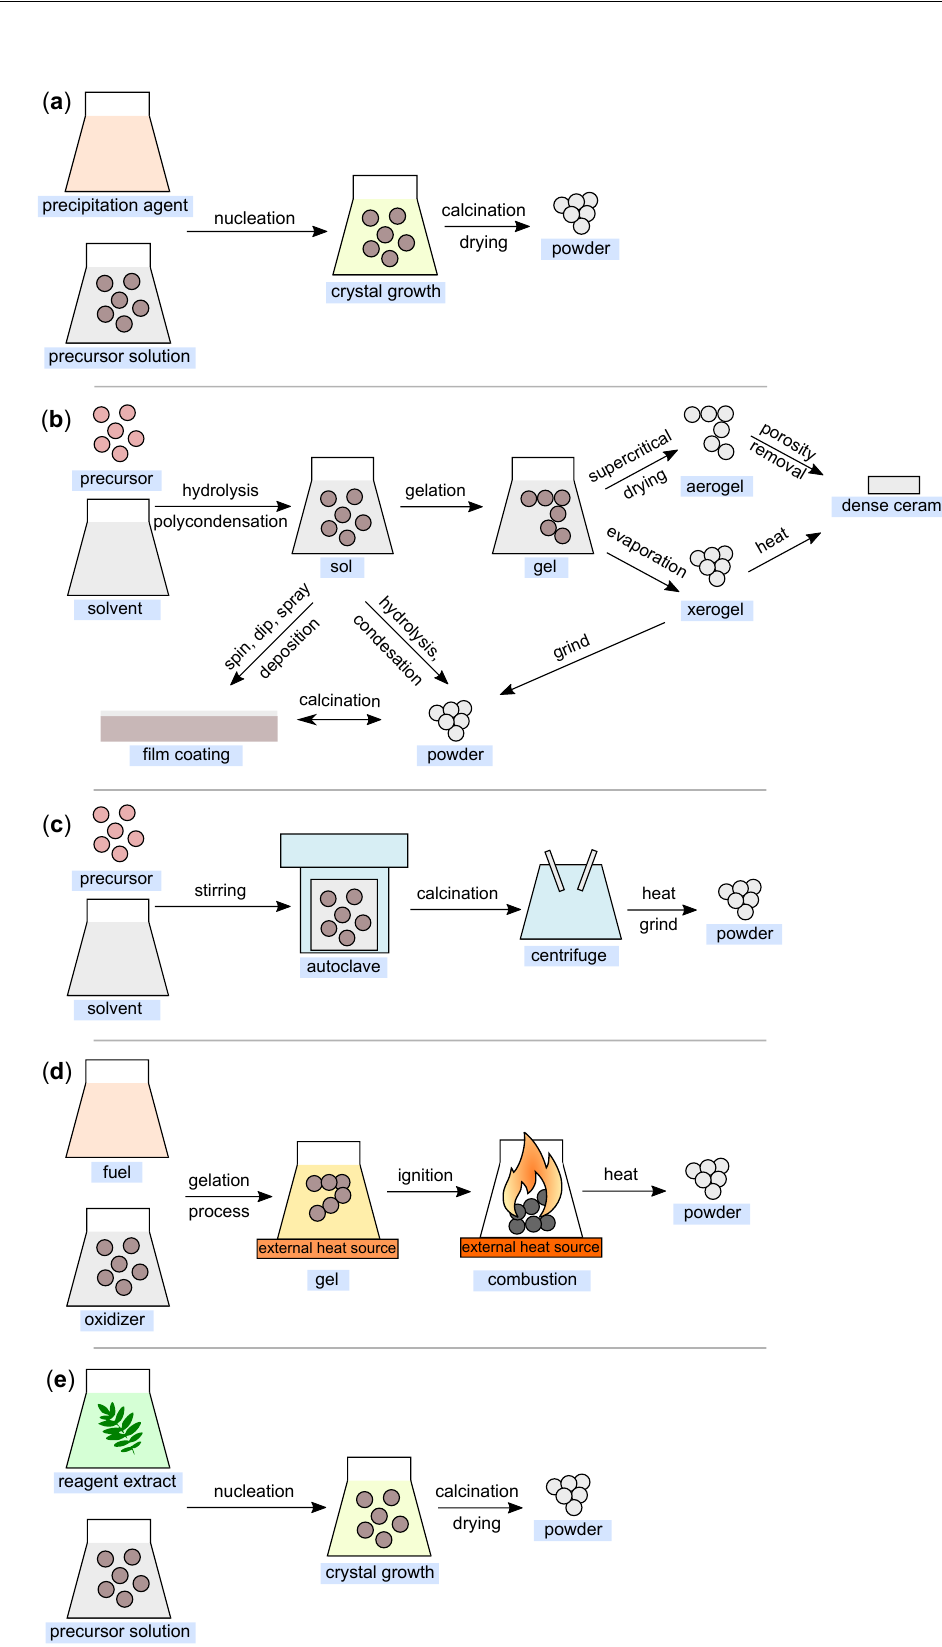
Figure 6. Illustration of nanoparticle synthesis using the ( a ) co-precipitation method; ( b ) sol–gel method; ( c ) hydrothermal method; ( d ) combustion method; and ( e ) green synthesis (all figures are redrawn and adapted from